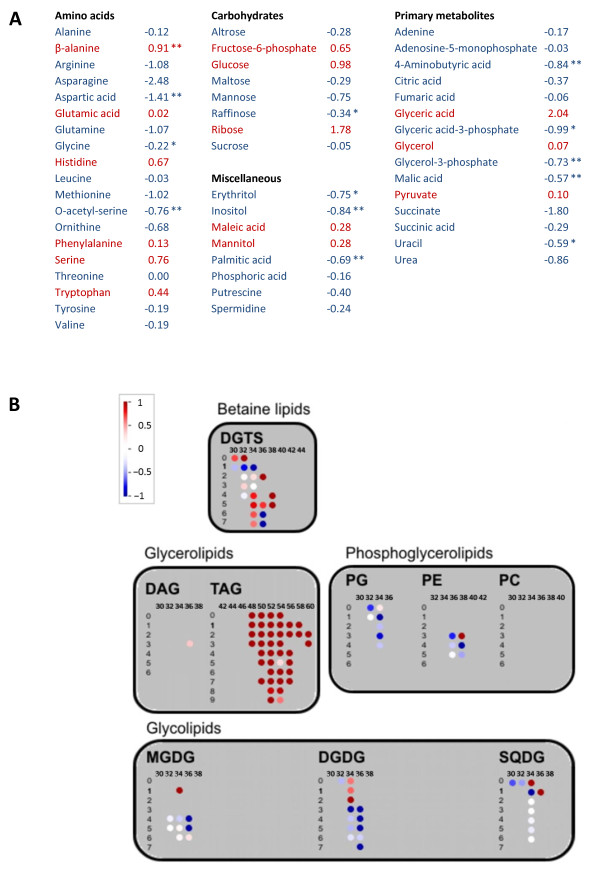
Metabolomic profiling of VMP1-deficient cells versus empty-vector control. (A) List of metabolites analyzed by GC-MS. The numbers represent log2 fold-change in the mutant compared to empty-vector control; positive numbers (red) denote accumulation in the mutant, negative numbers (blue): accumulation in empty-vector control. A single star (*) indicates p < 0.05; double stars (**) indicate p < 0.01. (B) Heat map of the lipids measured, sorted according to lipid class, carbon-chain length and number of double bonds. The schematic, produced by MapMan [24], shows the lipids' log2 fold-change in the mutant compared to empty-vector control: red circles denote lipid accumulation in the mutant, blue circles denote accumulation in empty-vector control, white circles denote nearly no change. For a comprehensive list with numeric values and statistical significance, see Additional file 4: Table S2.